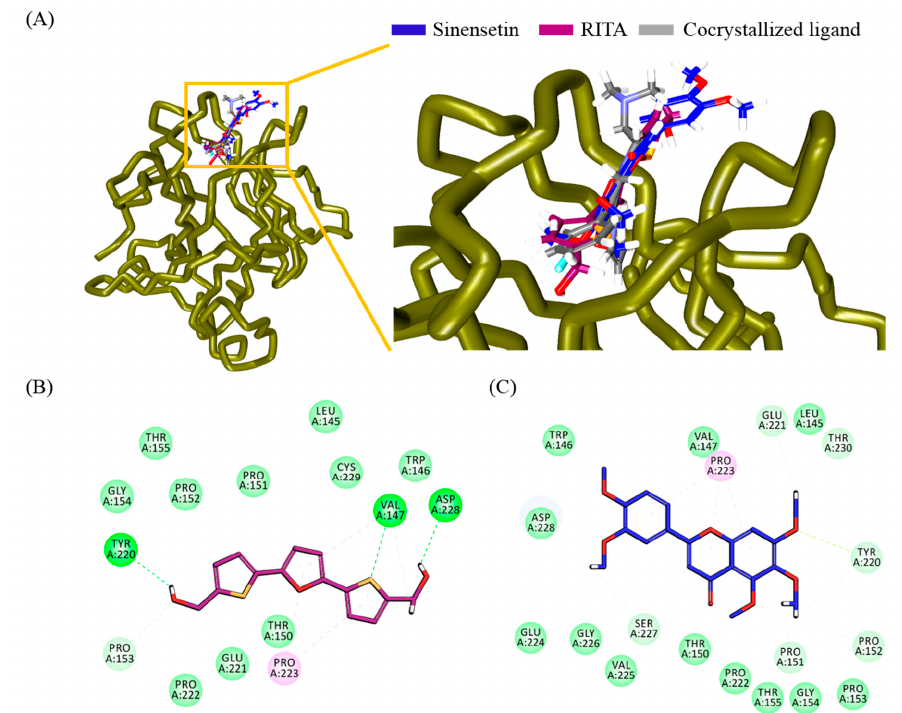
ffi nity assessment of the ligands at the binding pocket of the target. Figure 6 Figure 6. Binding a ( A ) Accommodation of SIN and RITA at the binding pocket of the protein. The left panel depicts the positioning of the ligands at the binding pocket, and the right panel is its zoomed version. ( B ) Overall interactions between the compound RITA and the protein residues. ( C ) Interactions between SIN and protein